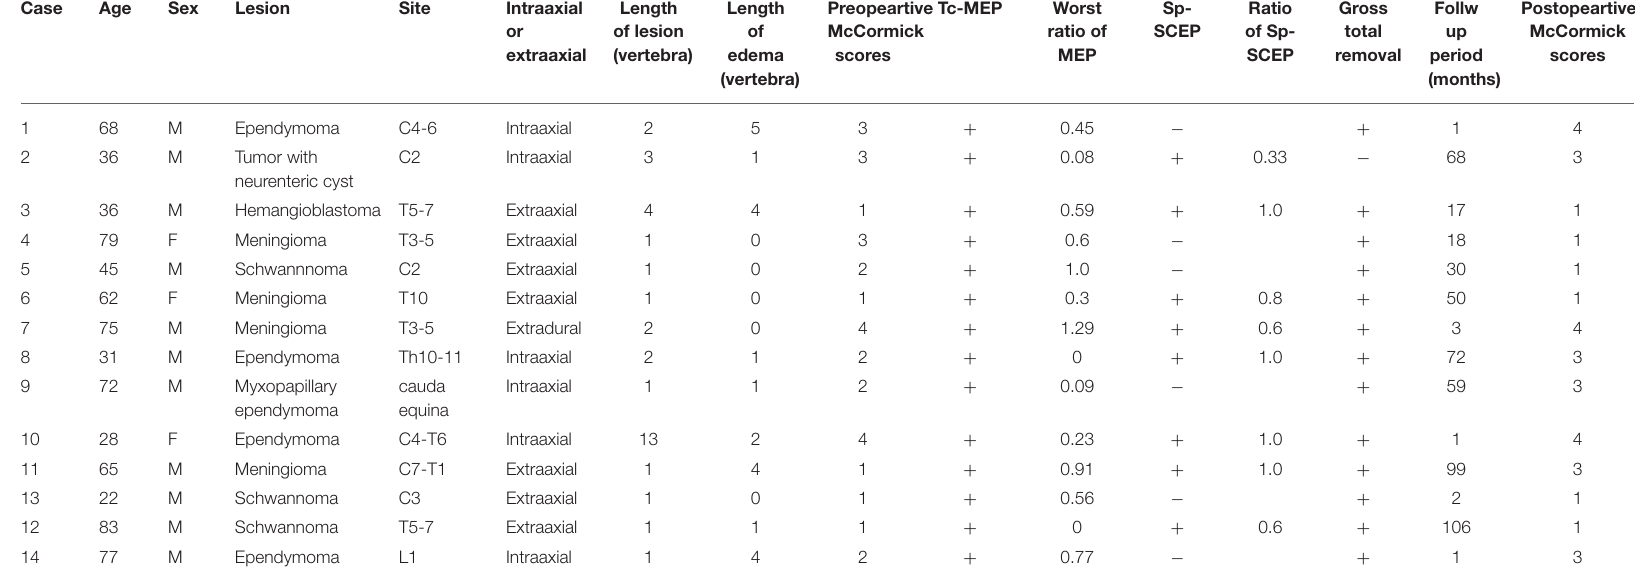
TABLE 1 | Summary of clinical data for the 14 patients receiving spinal tumor